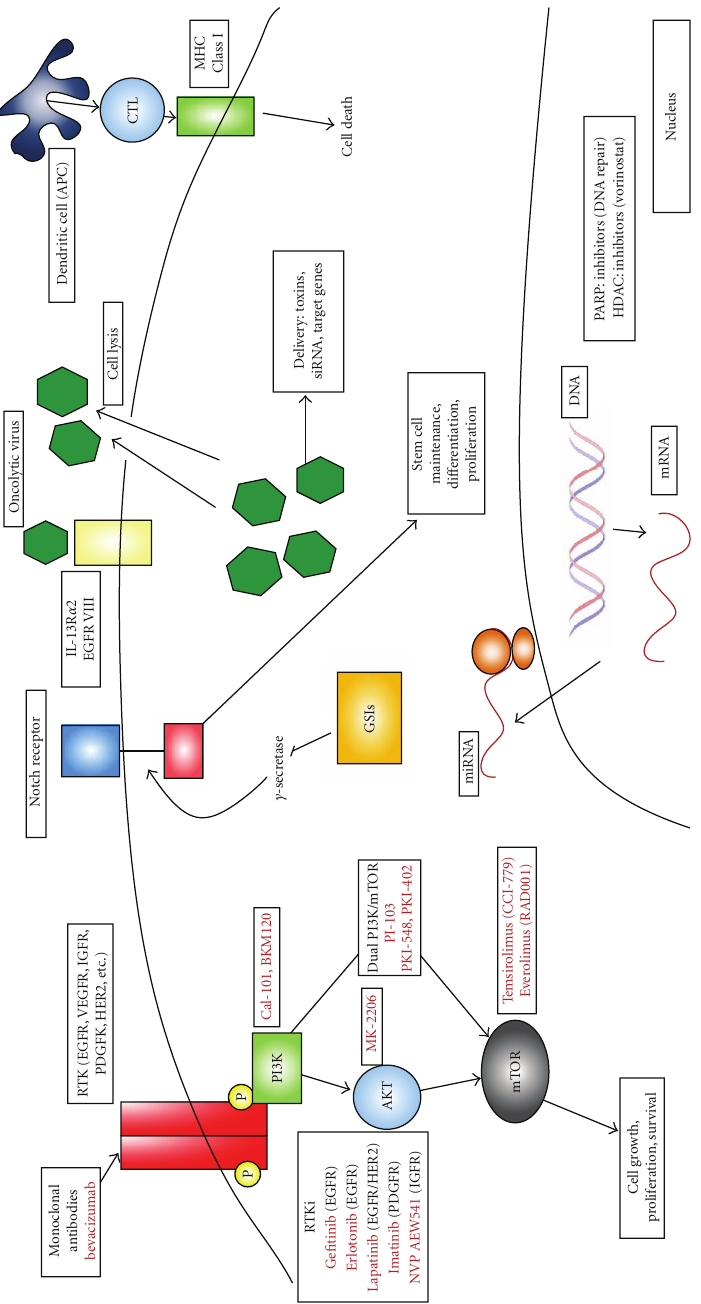
Figure 1: Novel therapies in GBM. RTKs and survival signaling pathways are major drug targets in GBM. Receptors have been targeted extracellularly by monoclonal antibodies or intracellularly at the tyrosine kinase domain. Major nodes in survival signaling pathways (P13K, AKT, mTOR) have been the focus of intense study and drug development. More recent approaches include stem-cell targeting (GSIs), inhibition of DNA rapair (PARP inhibitors), and targeting a host of cellular pathways through microRNA manipulation. Novel tumor cell killing approaches are also being studied. Oncolytic virus therapy, either alone or in combination with targeted agent delivery and immunotherapy, are being employed to e ffi ciently kill tumor cells while sparing normal tissue. RTK, receptor tyrosine kinase; EGFR, epidermal growth factor receptor; VEGFR, vascular endothelial growth factor receptor; IGFR, insulin-like growth factor receptor 1; PDGFR, platelet-derived growth factor receptor; mTor, mammalian target of rapamycin; GSI, gamma-secretase inhibitor; APC, antigen-presenting cell; CTL, cytotoxic T lymphocyte, MHC class I, major histocompatibility complex I; PARP, poly(ADP-ribose) polymerase; HDAC, histone deacetylase